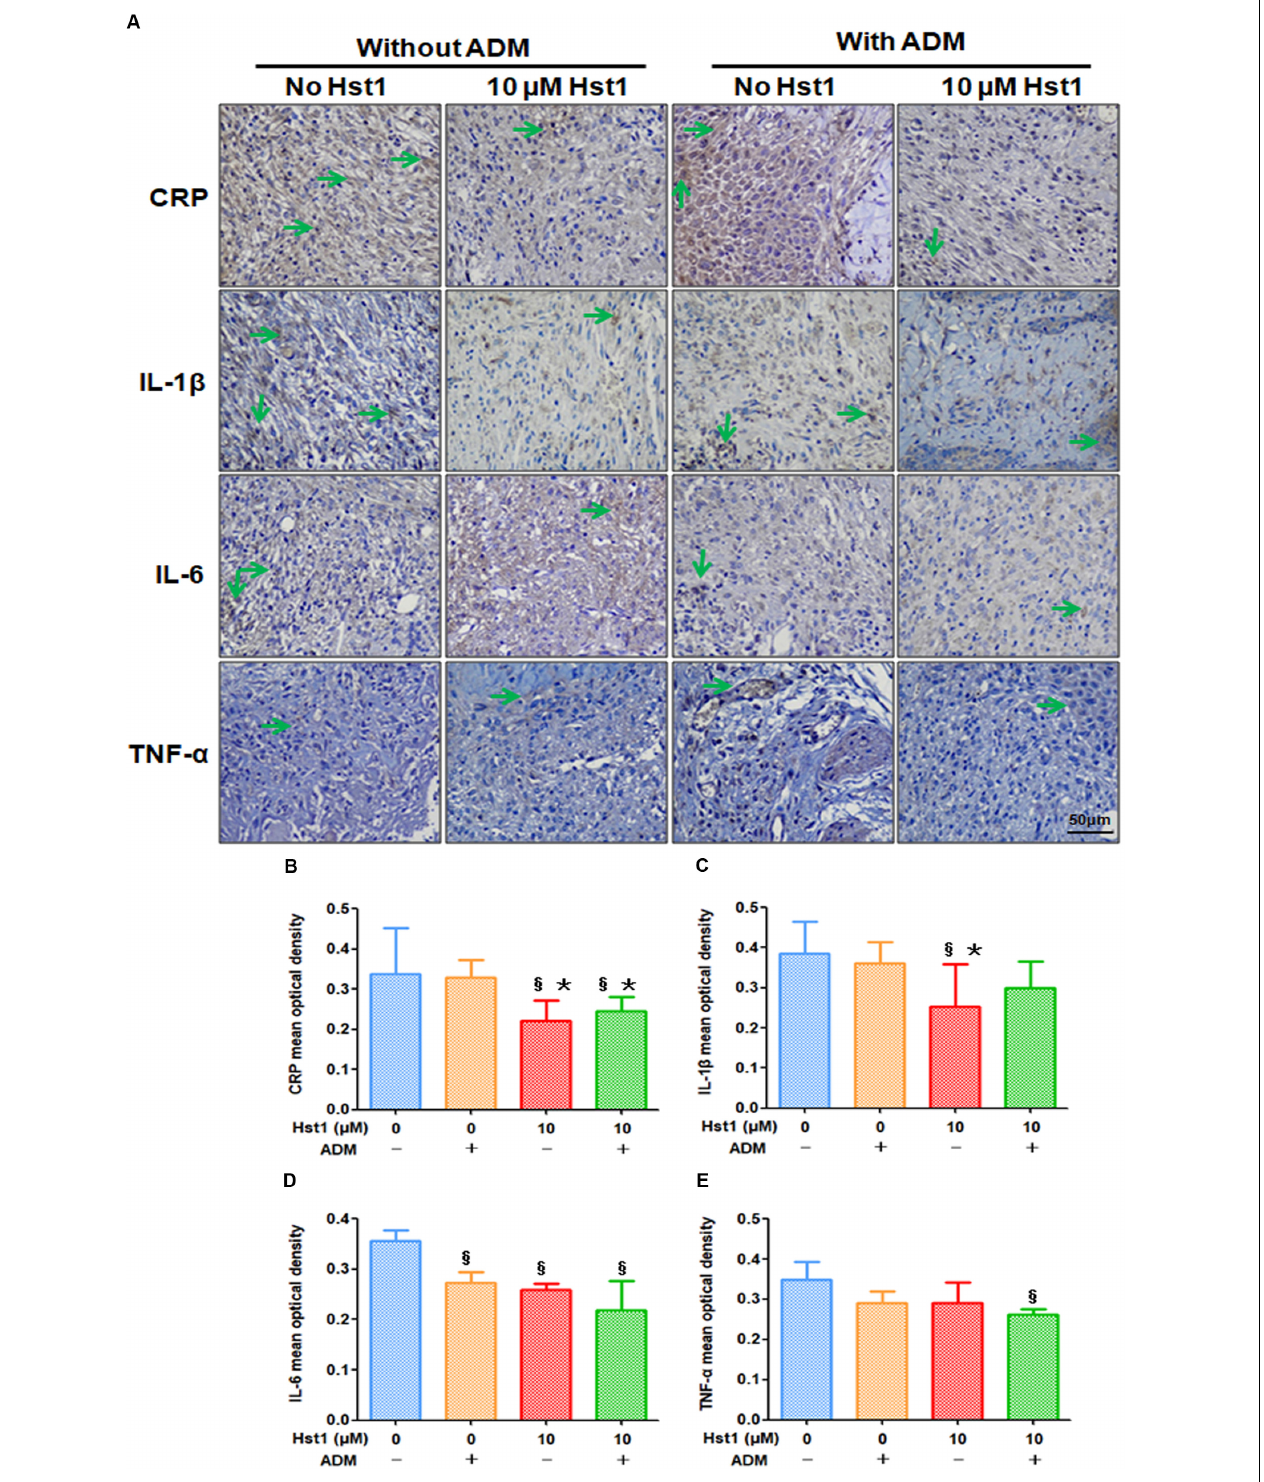
FIGURE 7 | Immunohistochemical evaluation of the expression levels of CRP, IL-1 β , IL-6, TNF- α at wound sites. (A) 14 days post-surgery, the positive expression level of CRP, IL-1 β , IL-6, TNF- α (in green arrows) in the 10 µ M Hst1 group was lower. The scale bar = 50 µ m; (B–E) . Quantitative analysis of the expression level of CRP, IL-1 β , IL-6, TNF- α at wound sites. On day 7 post-surgery, 10 µ M Hst1 was associated with significantly lower levels of CRP, IL-1 β , IL-6 and TNF- α than the control group. §: The 10 µ M Hst1 group, 10 µ M Hst1 + ADM group and ADM group vs the control group; *: The 10 µ M Hst1 group and 10 µ M Hst1 + ADM group vs the ADM group ( P <